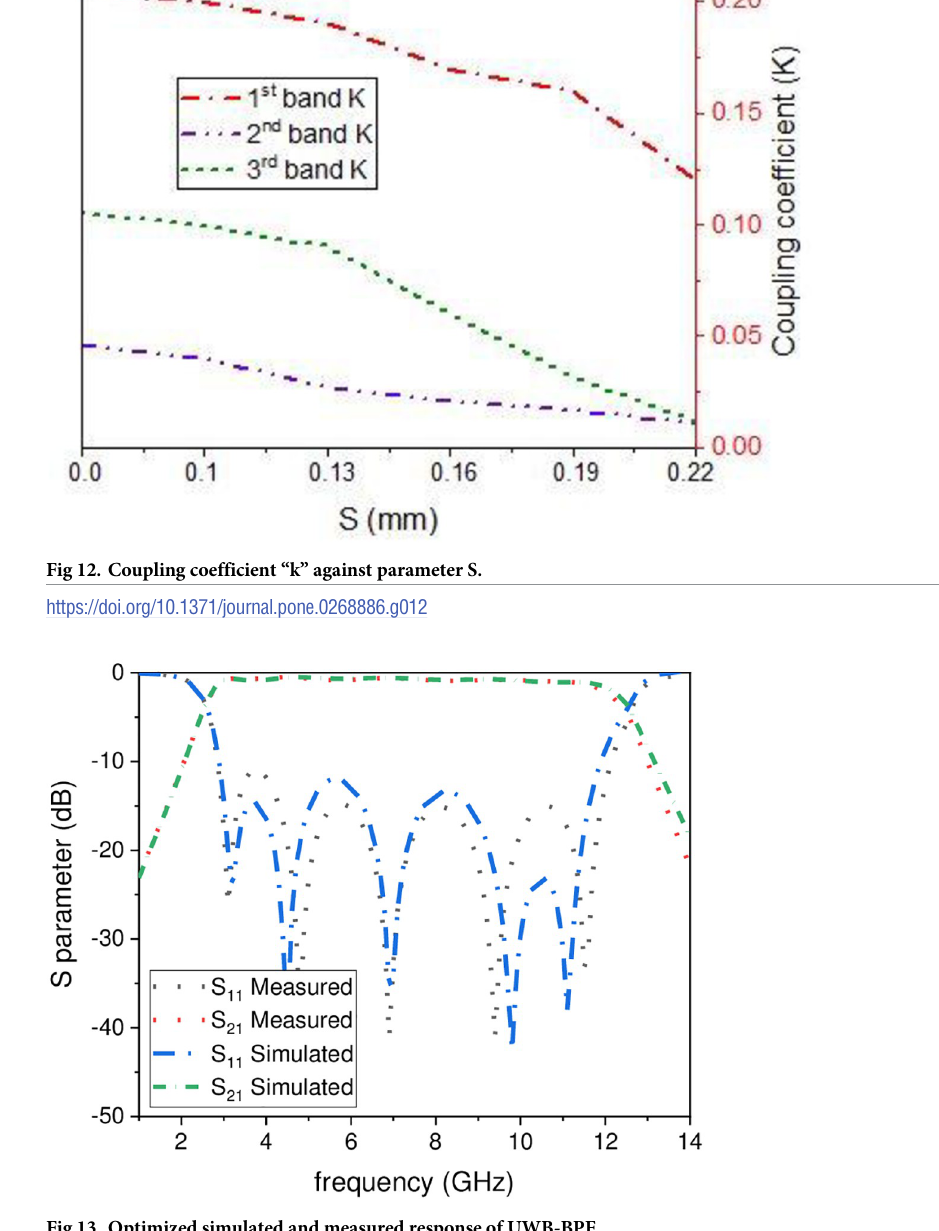
Fig 13. Optimized simulated and measured response of UWB-BPF.